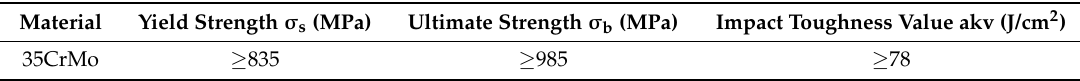
Figure 3. Geometry and dimensions of the specimen (unit: mm). Table 1. Chemical components (%) of the specimen material. Table 2. Mechanical properties of the specimen material.